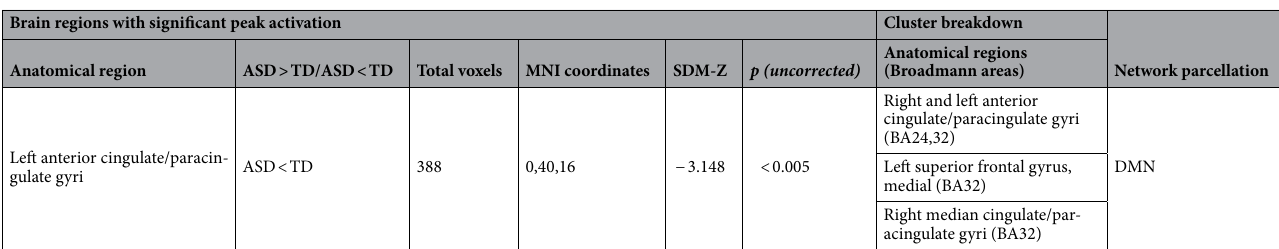
Table 4. fMRI meta-analysis on EC components (cognitive flexibility) with age as a